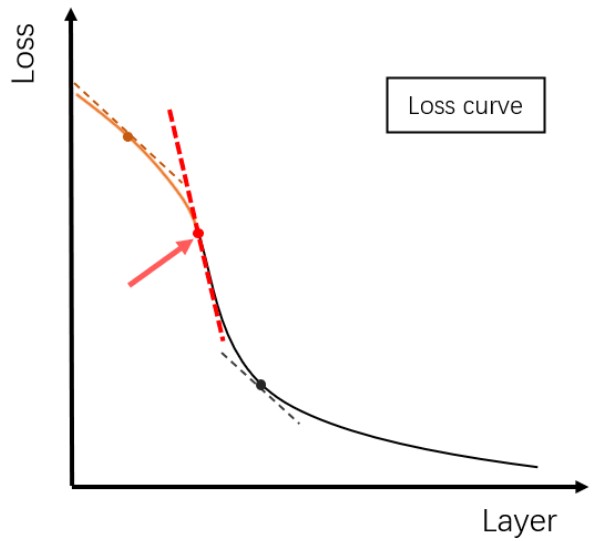
Figure 3. A rapid change in the gradient occurs near the loss curve of the appropriate frozen layer